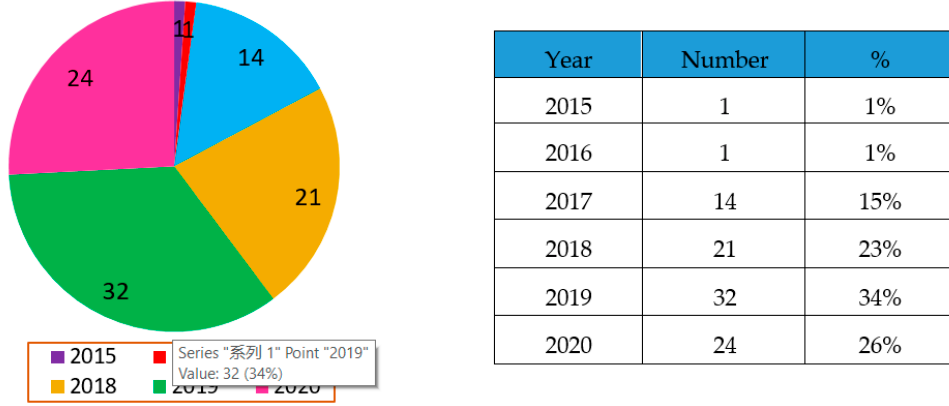
Figure 1. Related (Elephant Herding Optimization) EHO publications since 2015.